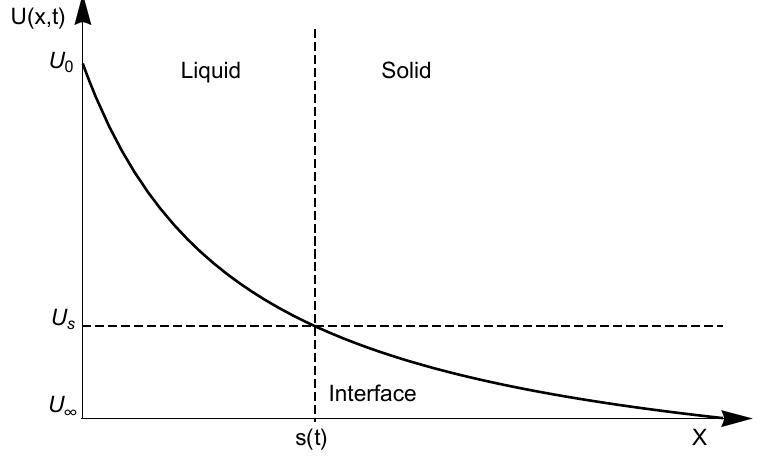
Figure 1. Semi-infinite slab melting from x = 0 due to the high temperature U 0